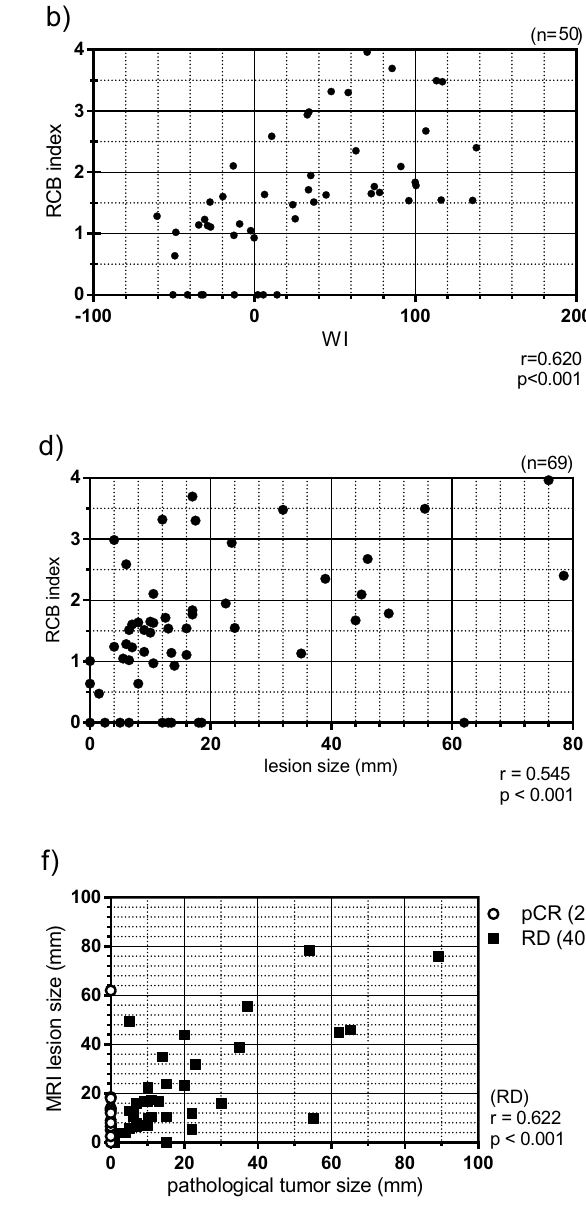
Figure 2. The correlations between DCE-MRI findings (WI and lesion size) and pathological responses (RCB index and pathological tumor size). The correlation between WI and RCB index was shown at ( a ) MRI mid (n = 58) and at ( b ) MRI post (n = 50) and the correlation between lesion size on MRI and RCB index at ( c ) MRI mid (n = 62) and ( d ) MRI post (n = 69). The correlation between pathological tumour size and lesion size on MRI was shown at ( e ) MRI mid (n = 62) and at ( f ) MRI post (n = 69). At ( e ) and ( f ), both pCR group and RD group were plotted on the graph but the correlation coefficient was calculated only for RD group. The correlations were evaluated using Spearman’s correlations